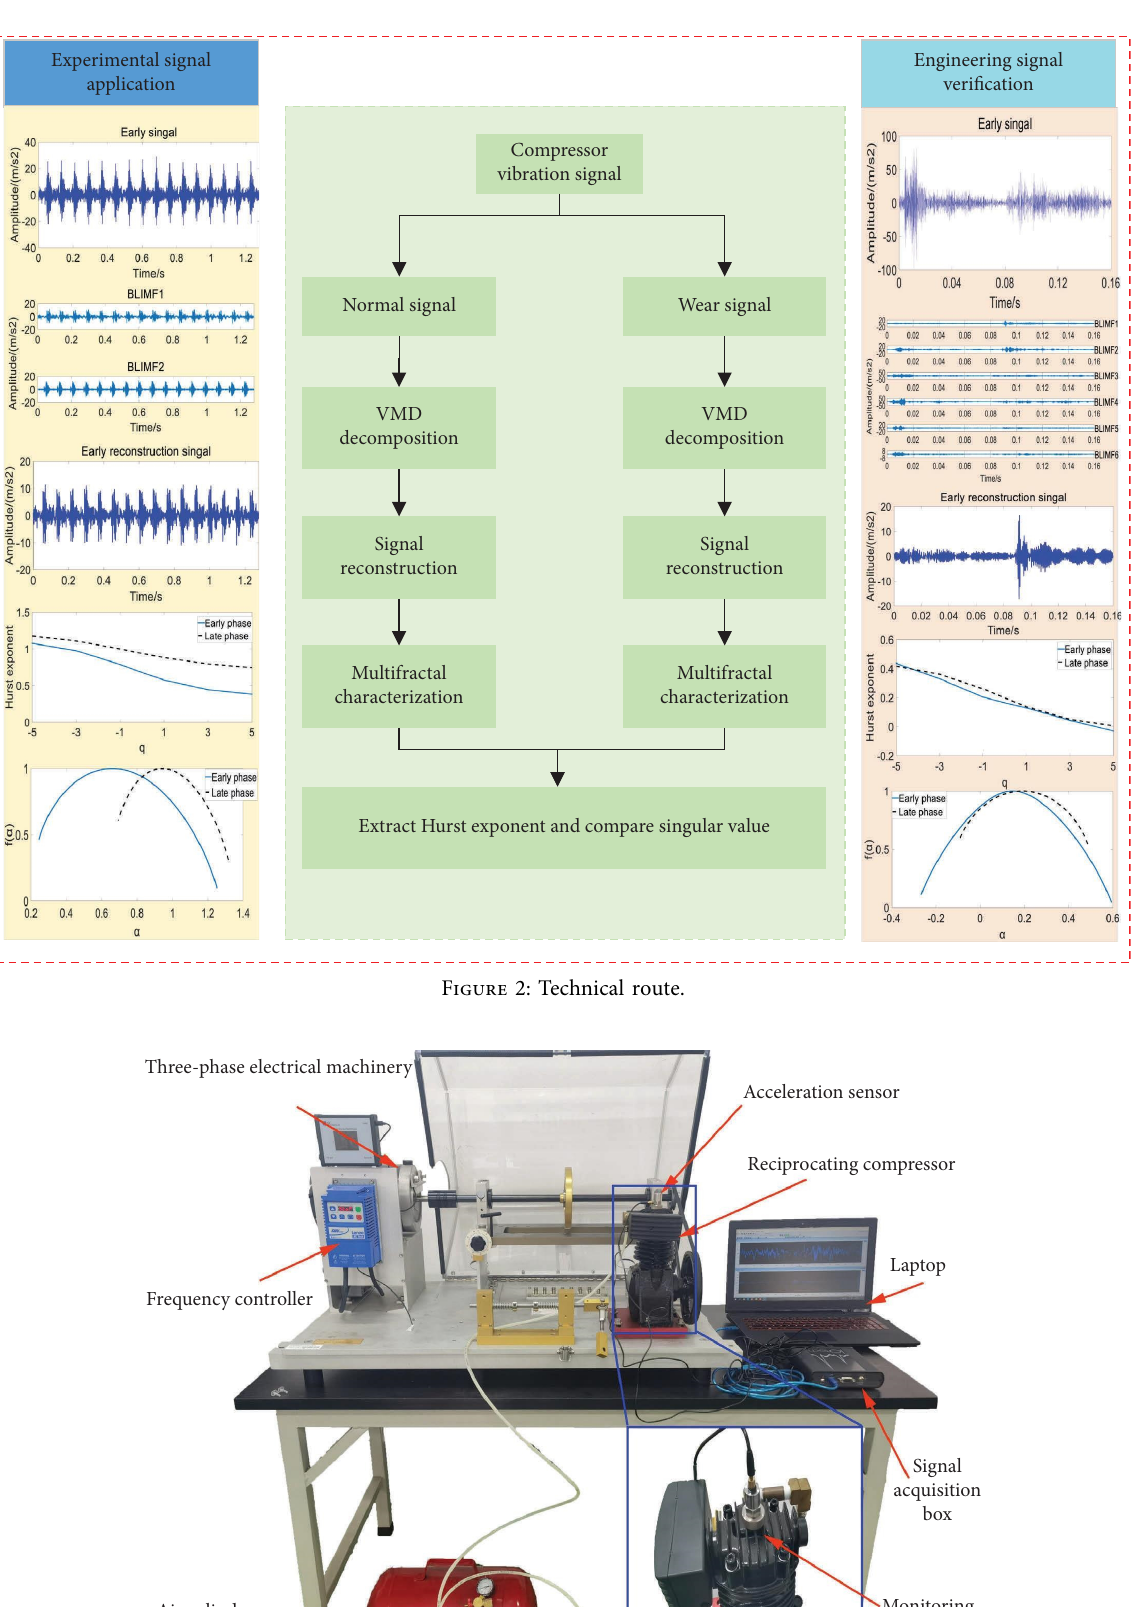
Figure 3: Experimental bench and test system.